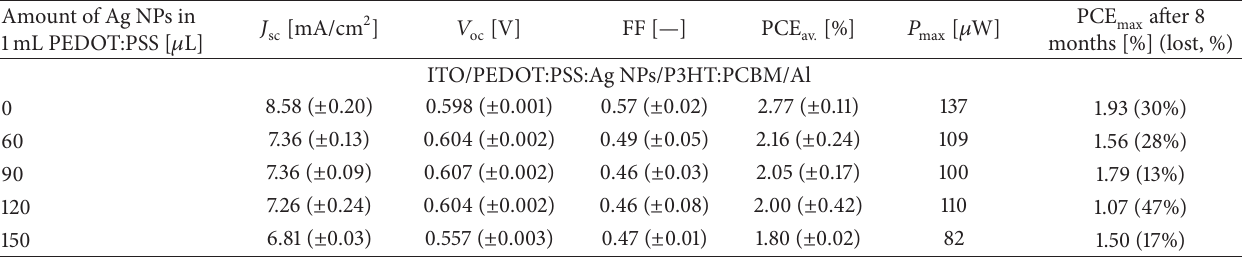
Table 3: Optimized PV performance for BHJ solar cells with Ag NPs under AM 1.5 G-simulated solar illumination (100mW/cm 2 ). Amount of Ag NPs